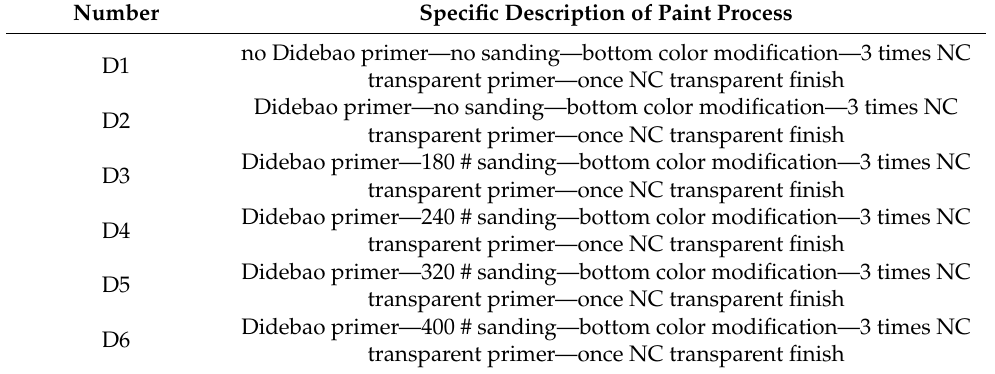
Table 4. The manufacture of specimens for Group